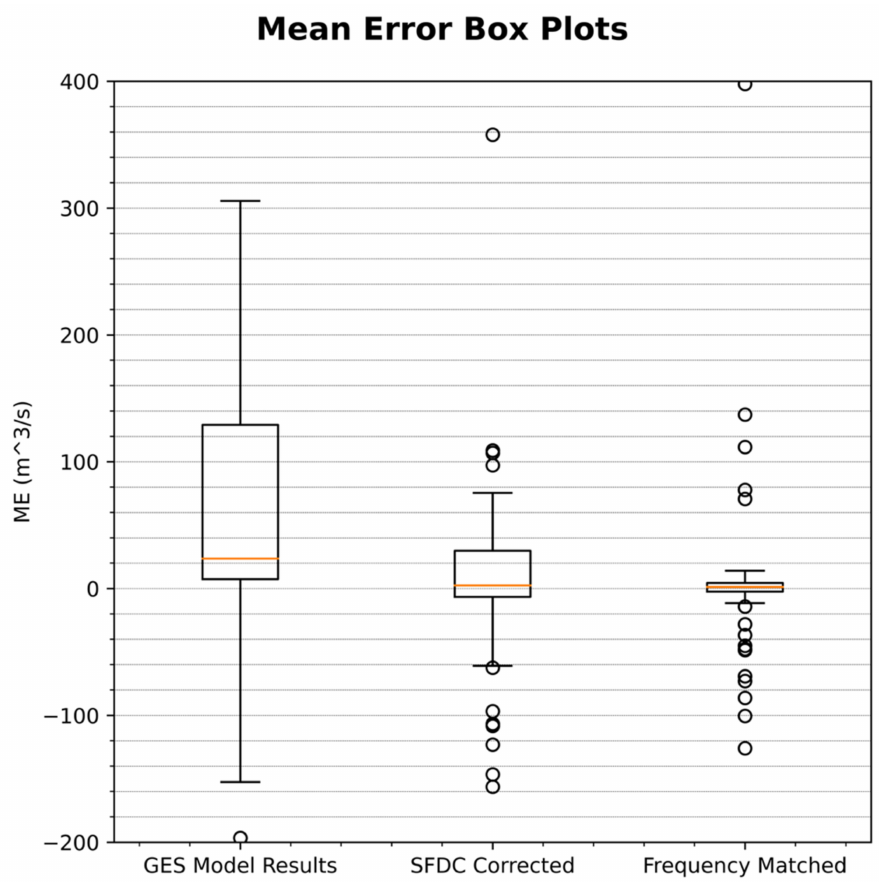
Figure 6. Box plots of mean error in the Magdalena River basin for each test group (outliers above 400 m 3 /s